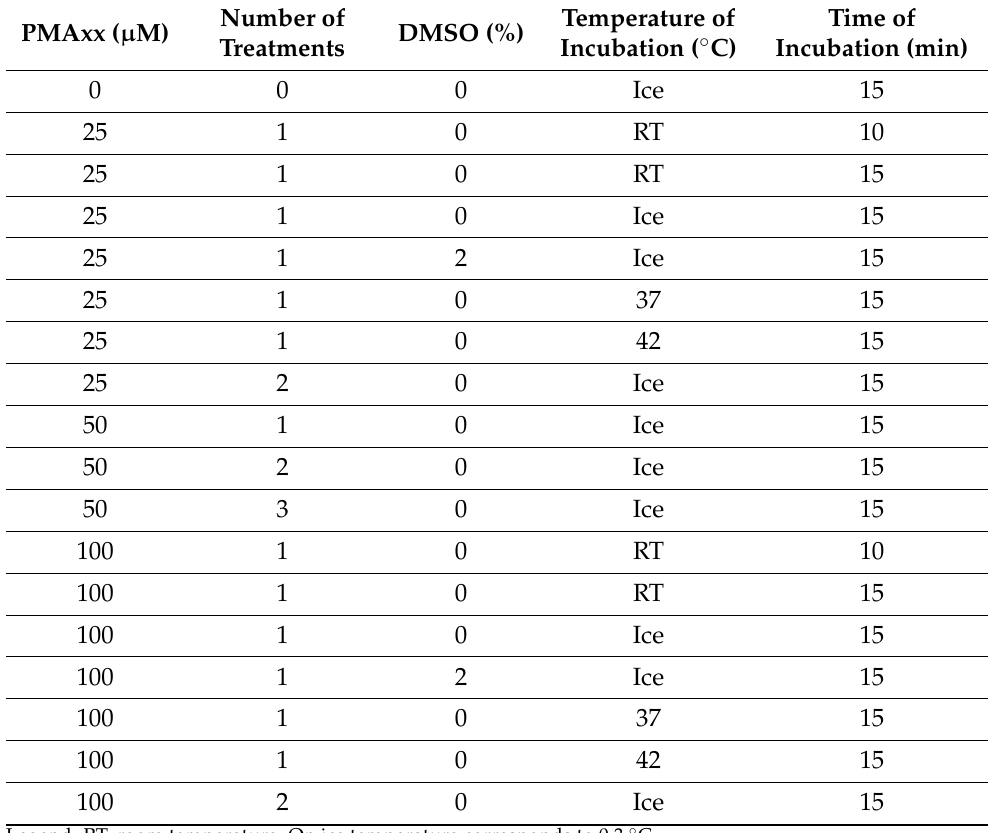
Table 1. Different PMAxx treatment protocols of log8.19 ( ± 0.17) G. swidsinskii cells incubated